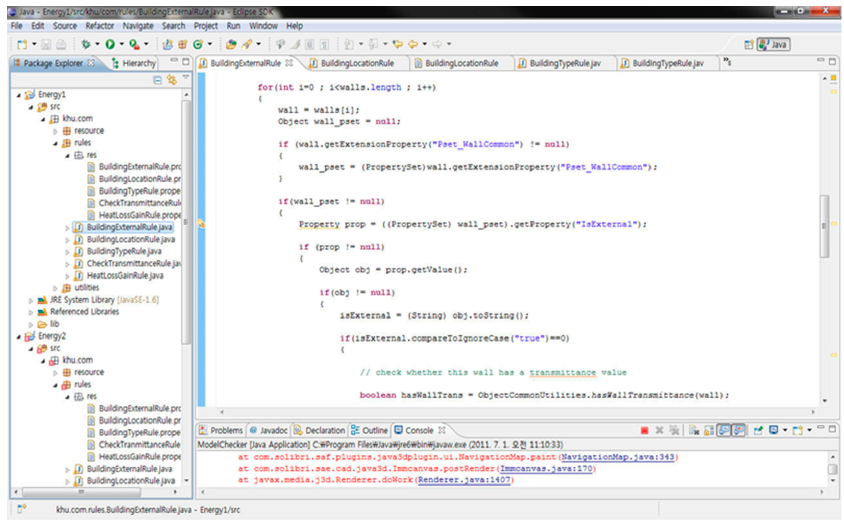
Figure 5. Eclipse Interface defining rules for building envelope property definition.